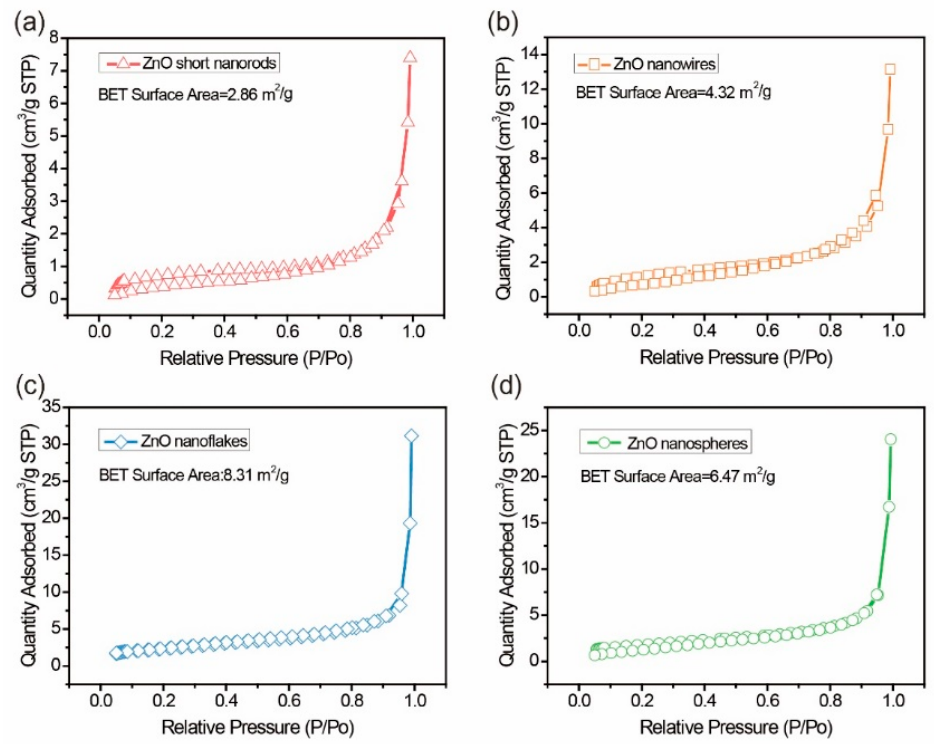
Figure 5. BET curves of ( a ) ZnO short nanorods, ( b ) ZnO nanowires, ( c ) ZnO nanoflakes, and ( d ) ZnO nanospheres.